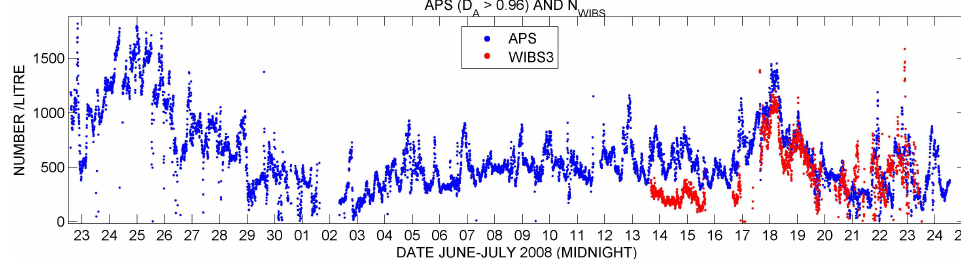
Fig. 11. Above-canopy number concentration time series from the APS and WIBS-3 in their common size range.